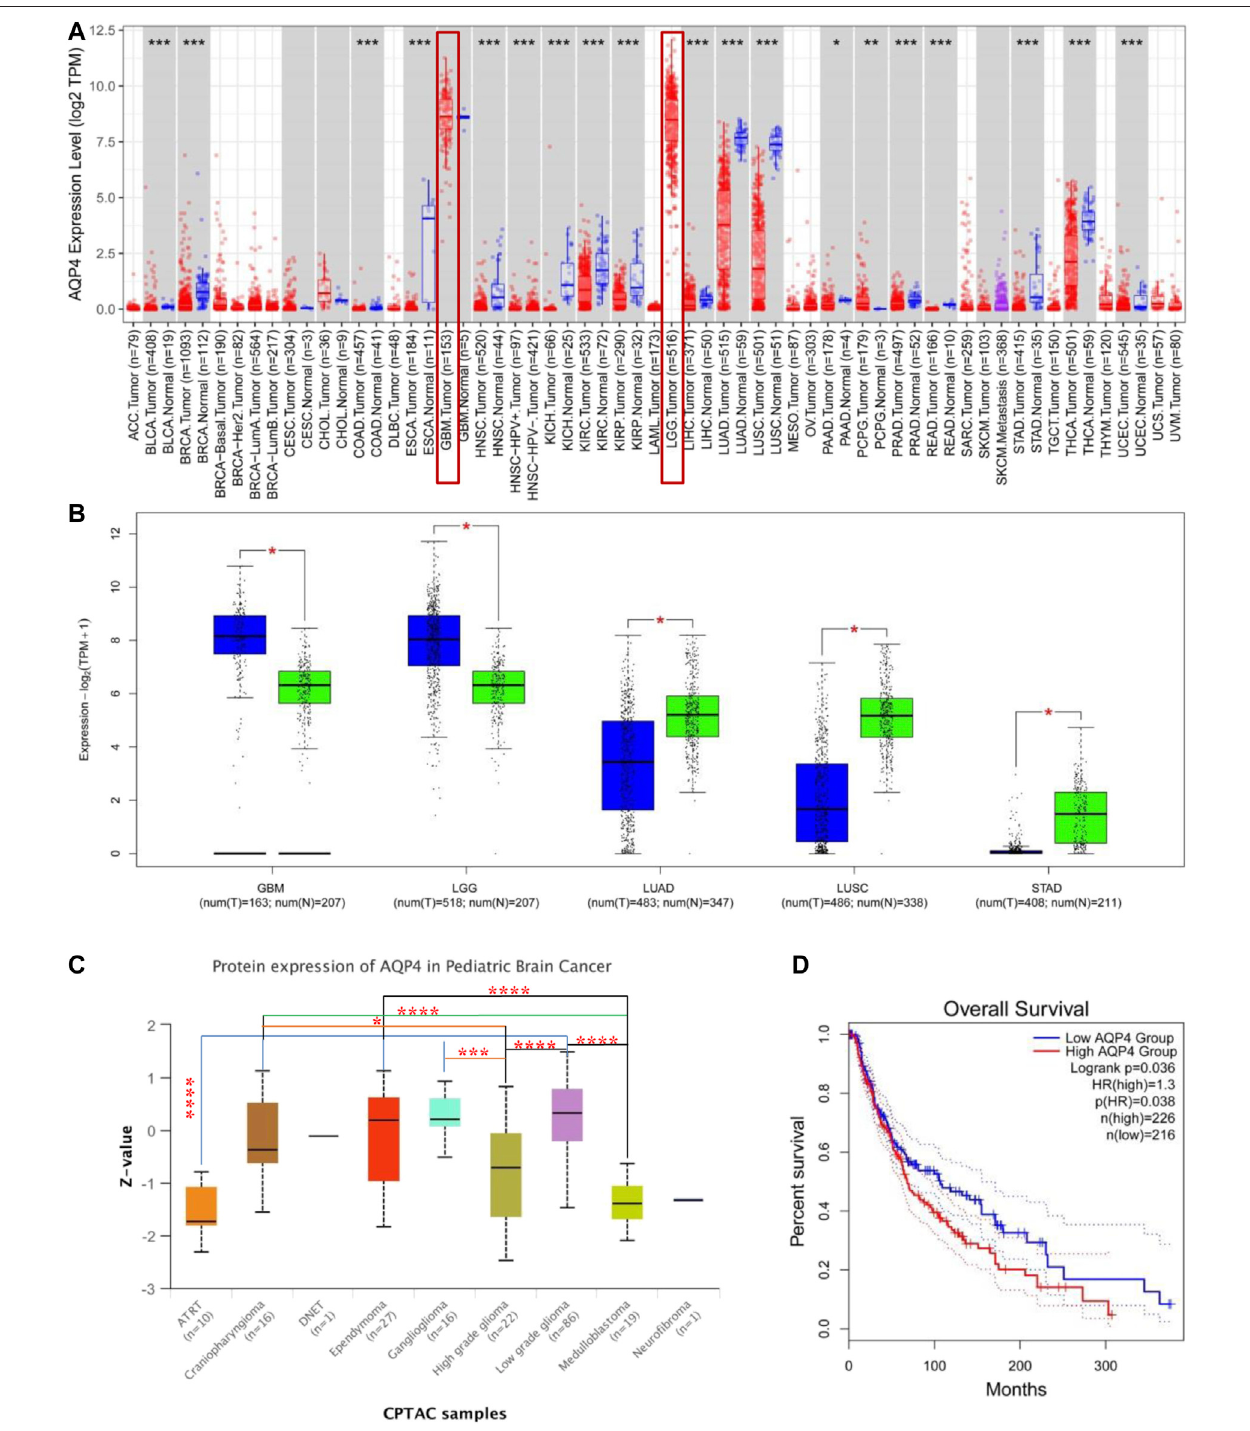
FIGURE1| AQP4geneexpressionacrossvarioustumorsandpathologicalstages. (A) TIMER2wasusedtodetermineAQP4expressionacrossdifferentcancers. * p < 0.05;** p < 0.01; *** p < 0.001. (B) TCGA database deriveddata onGBM, LGG, LUAD,LUSC and STAD cancers, withcontrolsbeing correspondingnormal tissues from the GTEx database. * p < 0.05 (C) AQP4 protein expression of normal tissue and pediatric brain cancer tissue from the CPTAC dataset was compared. (D) AQP4 geneexpressionandsurvivalofcancerpatients fromtheTCGAdatabasewascompared.TheGEPIA2toolwasusedtoperformoverallsurvivalanalysesofvarious cancers in TCGA based on expression of the SNRPG gene. The survival map and Kaplan-Meier curves are demonstrated. * p < 0.05; ** p < 0.01; *** p < 0.001; **** p < 0.0001.